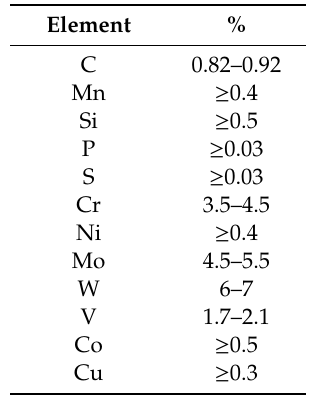
Table 4. Composition of HS6-5-2C